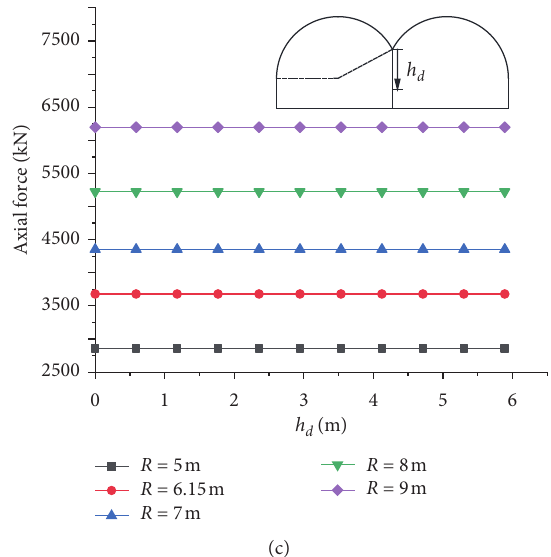
Figure 23: Variations of axial force with R: (a) along the arch ring; (b) along the side wall; (c) along the middle wall.